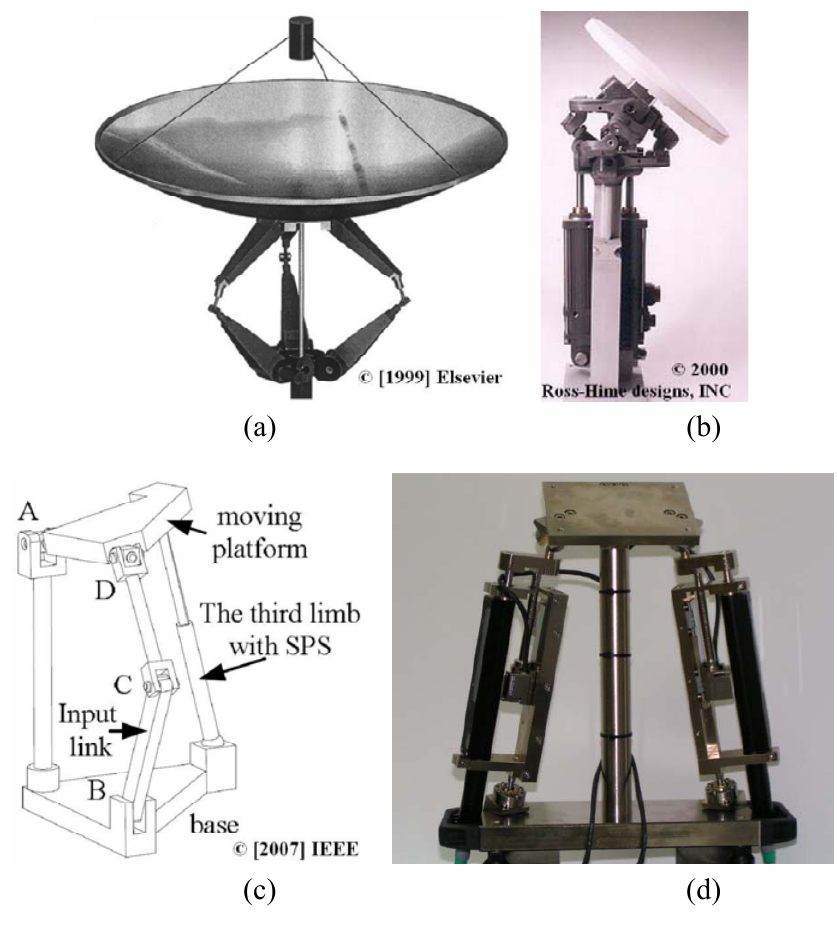
Figure 1. Two-DOF parallel robots: (a) Dunlop design (reprinted from [16] with permission from Elsevier). (b) Omni-wrist from Rosheim [17] (reprinted with permission from Rosheim). (c) Zeng design (reprinted from [15] with permission from IEEE). (d) Majarena design